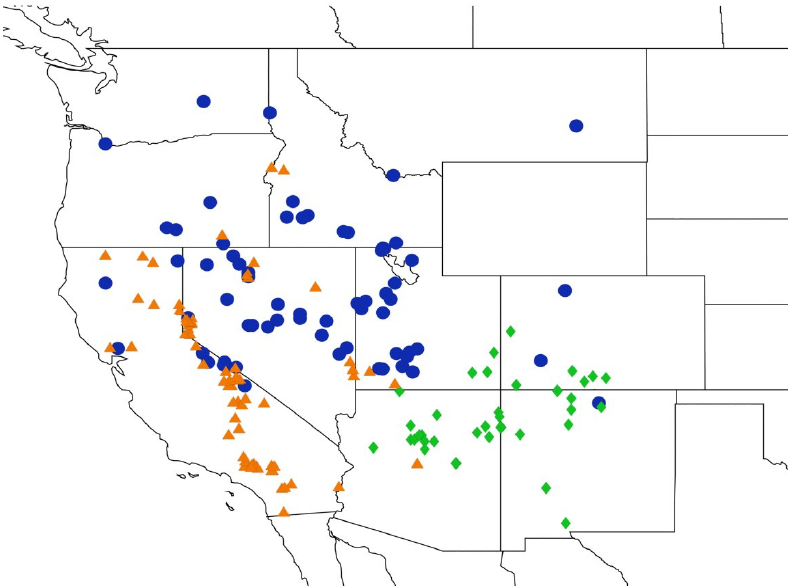
Figure 57. Distribution of Okanagana gibbera (blue circles), O. cruentifera (orange triangles) and O. fumipennis (green diamonds).